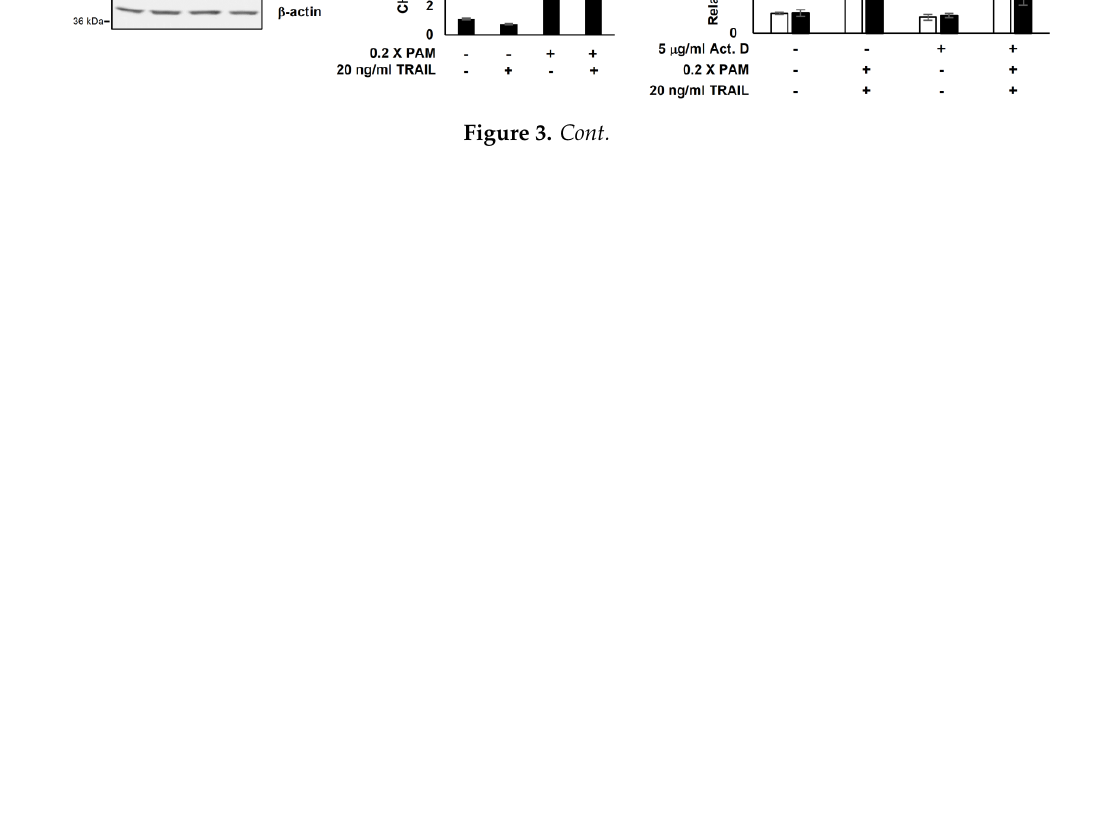
Figure 3. PAM/TRAIL induces DR5 upregulation through CHOP-mediated transcription. ( a ) HeLa cells were treated with 0.2× PAM alone or PAM/TRAIL. After 24 h, proteins in cell lysates were separated by sodium dodecyl sulfate polyacrylamide gel electrophoresis and immunoblotting with antibodies against CHOP, DR5, and β-actin. ( b ) HeLa cells were treated as described in ( a ). After 24 h, CHOP mRNA levels were determined via qRT-PCR. GAPDH was used as an internal control. ( c ) HeLa cells were co-treated with PAM/TRAIL for 12 h. Afterwards, the culture was replaced with fresh medium, pretreated with or without 5 μg/mL actinomycin D (Act D) for 30 min, and co- treated with or without PAM/TRAIL for 10 h. mRNA levels of CHOP and DR5 were determined via qPCR. ( d , e ) HeLa cells were transfected with a plasmid expressing either CHOP shRNA (shCHOP) or control shRNA (shCTL). At 24 h after transfection, cells were treated with PAM, TRAIL, or PAM/TRAIL for an additional 24 h. ( d ) Levels of CHOP and DR5 mRNA were determined via qRT- PCR. ( e ) Protein levels of CHOP and DR5 were determined by immunoblot analysis using antibodies against DR5 and CHOP. ( f ) Chromatin immunoprecipitation (ChIP) was performed using anti-CHOP antibody in HeLa cells following PAM/TRAIL treatment for 8 h. The IgG was used to control for antibody specificity. qRT-PCR was carried out using primers surrounding the CHOP binding sites in the DR5 promoter. * p < 0.05, ** p < 0.01, *** p < 0.001. 2.5. Plasma-Activated Medium (PAM) Promotes Membrane-Bound DR5 Redistribution Next we investigated the effect of PAM treatment on the expression and clustering of DR5 on the membrane, similarly to the case of the membrane-bound death receptor Fas whose forced redistribution and aggregation into ceramide-rich lipid platforms enhance FasL-mediated apoptosis [26]. Undiluted and 0.5× PAM enhanced the membrane clustering of DR5 in HeLa and HT-29 cells, inducing its redistribution in a dose- and time-dependent manner (Figure 4a,b). Because the ligand TRAIL is required for DR5 membrane clustering [27] and we showed that the lethal-dose (undiluted and 0.5×) of PAM promoted DR5 clustering on the membrane (Figure 4a,b), we examined whether PAM could induce TRAIL expression. We evaluated the TRAIL mRNA levels with and without PAM treatment. The TRAIL mRNA levels were barely affected by the sublethal- (0.2×) and lethal (0.5×) doses of PAM (Supplementary Figure S6), indicating that the PAM-mediated DR5 redistribution on the membrane may occur in a TRAIL-independent manner. Since a previous study showed that up-regulated DR5 induces TRAIL-independent apoptosis